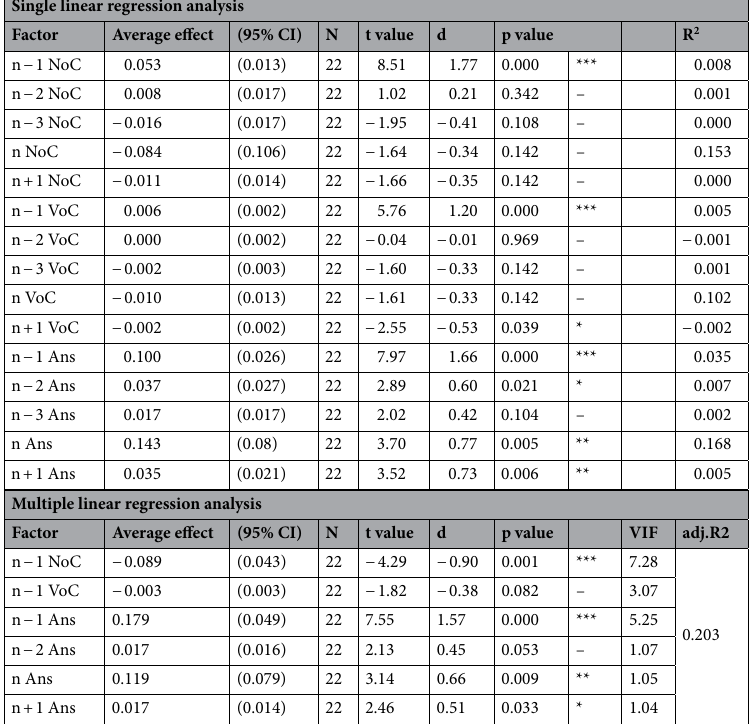
Table S1 in the Supplementary Information, the results of the ridge regression were similar to those of Table 1. No change in the sign of the explanatory variables was observed. These results suggest that multicollinearity did not seriously affect the results of the multiple regression analysis. See Supplemental information for details on the ridge analysis. The correlation matrix between all explanatory and objective variables entered into the multiple regression analysis is shown in Fig. S13.